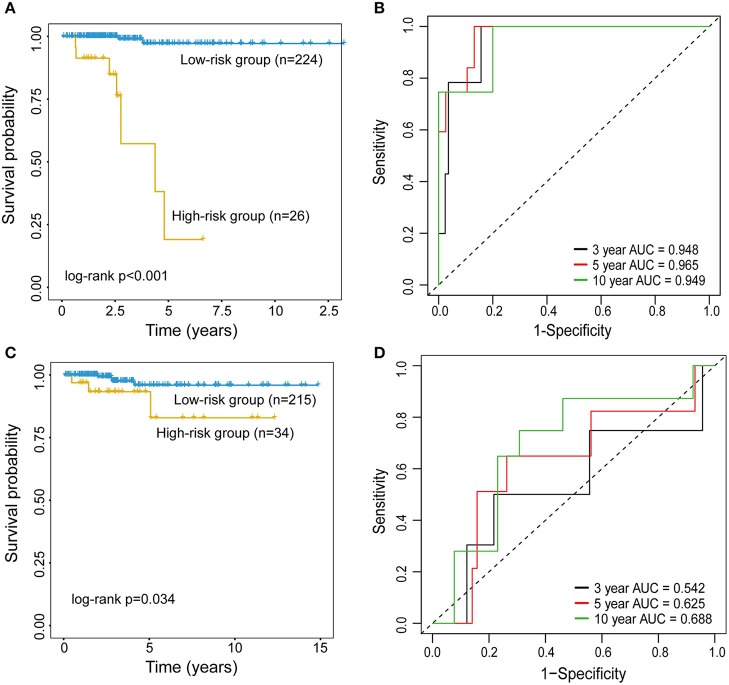
Performance evaluation of the EpiLncPM for survival prediction. Kaplan-Meier survival curves for the high- and low-risk groups in the training (A) and testing (C) datasets. The time-dependent receiver operating characteristic (ROC) curve analysis for survival prediction at three, 5 and 10-year survival rates in the training (B) and testing (D) datasets.